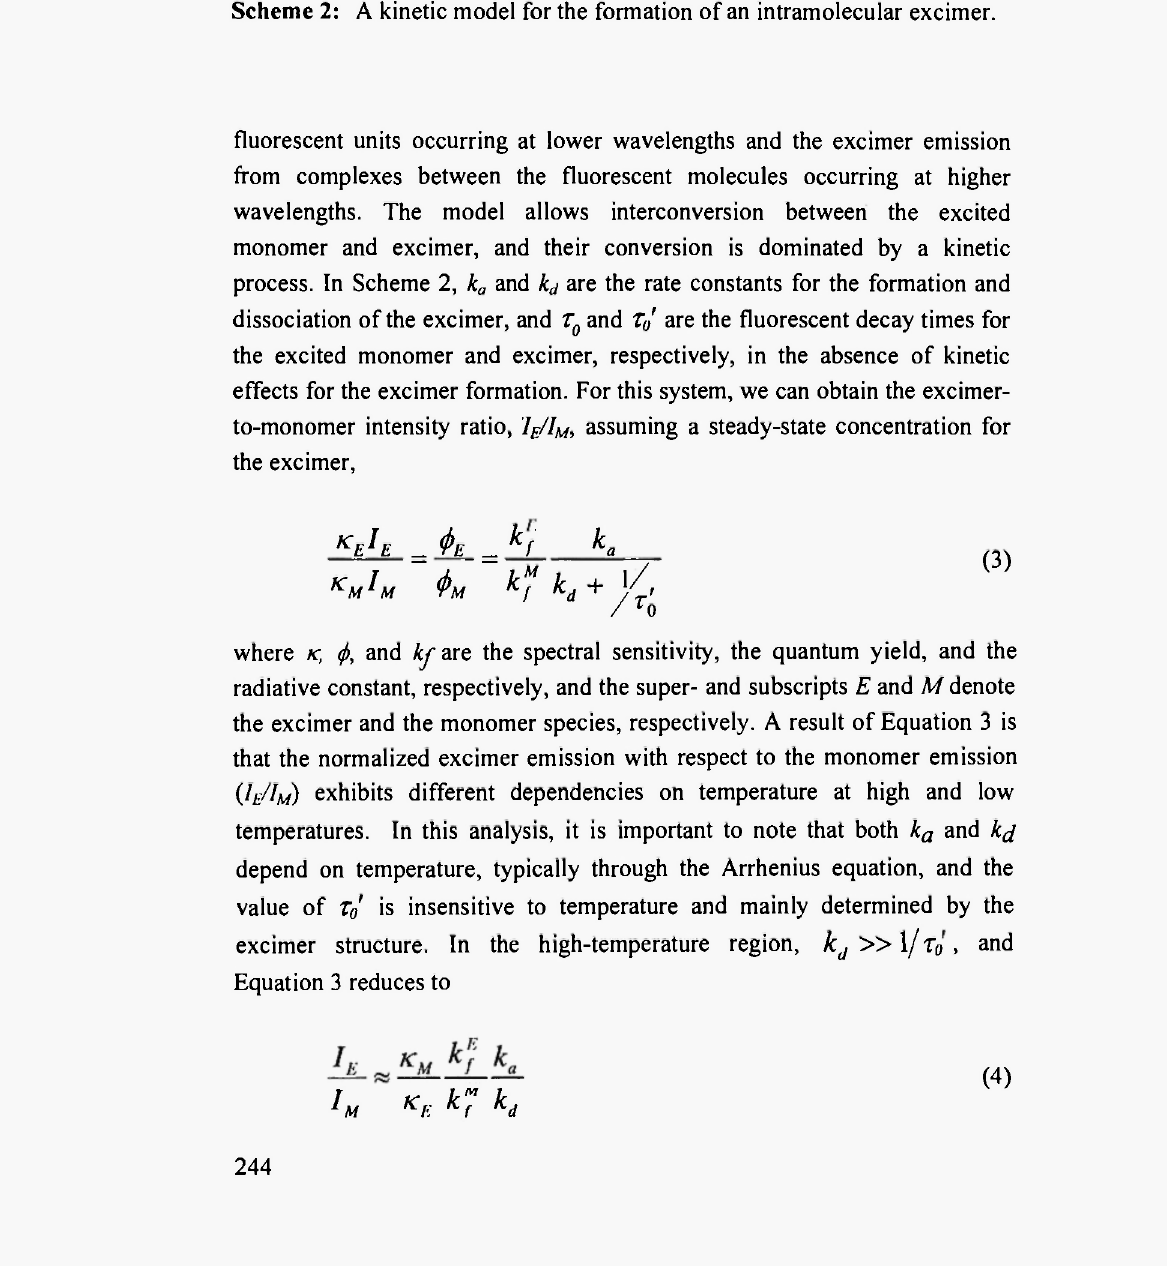
Scheme 2: A kinetic model for the formation of an intramolecular excimer.